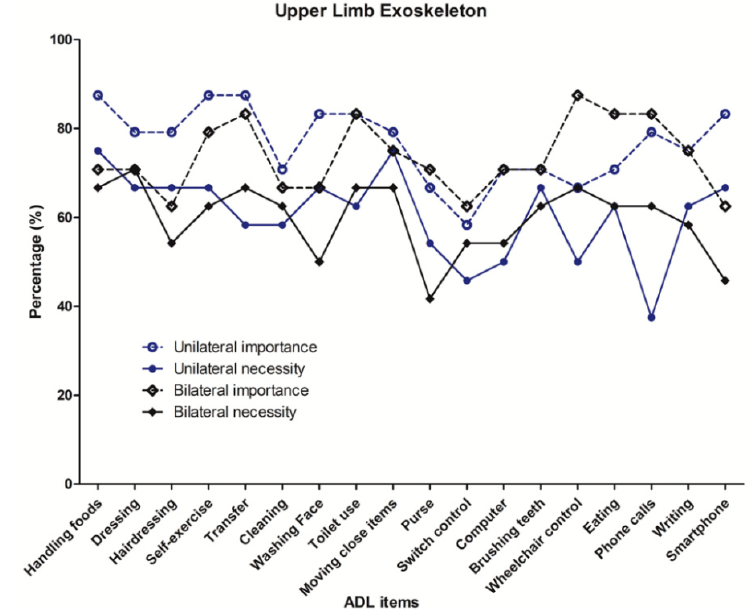
Figure 2. The percentage of respondents who replied ‘important’ or ‘very important’ for importance (dotted line) and ‘necessary’ and ‘highly necessary’ for necessity (solid line) of an upper limb exoskeleton to each ADL function in each impairment group (unilateral impairment group: circle, bilateral impairment group: rhombus). The ADLs in the x -axis are in the order of high to low dependency for all survey participants.